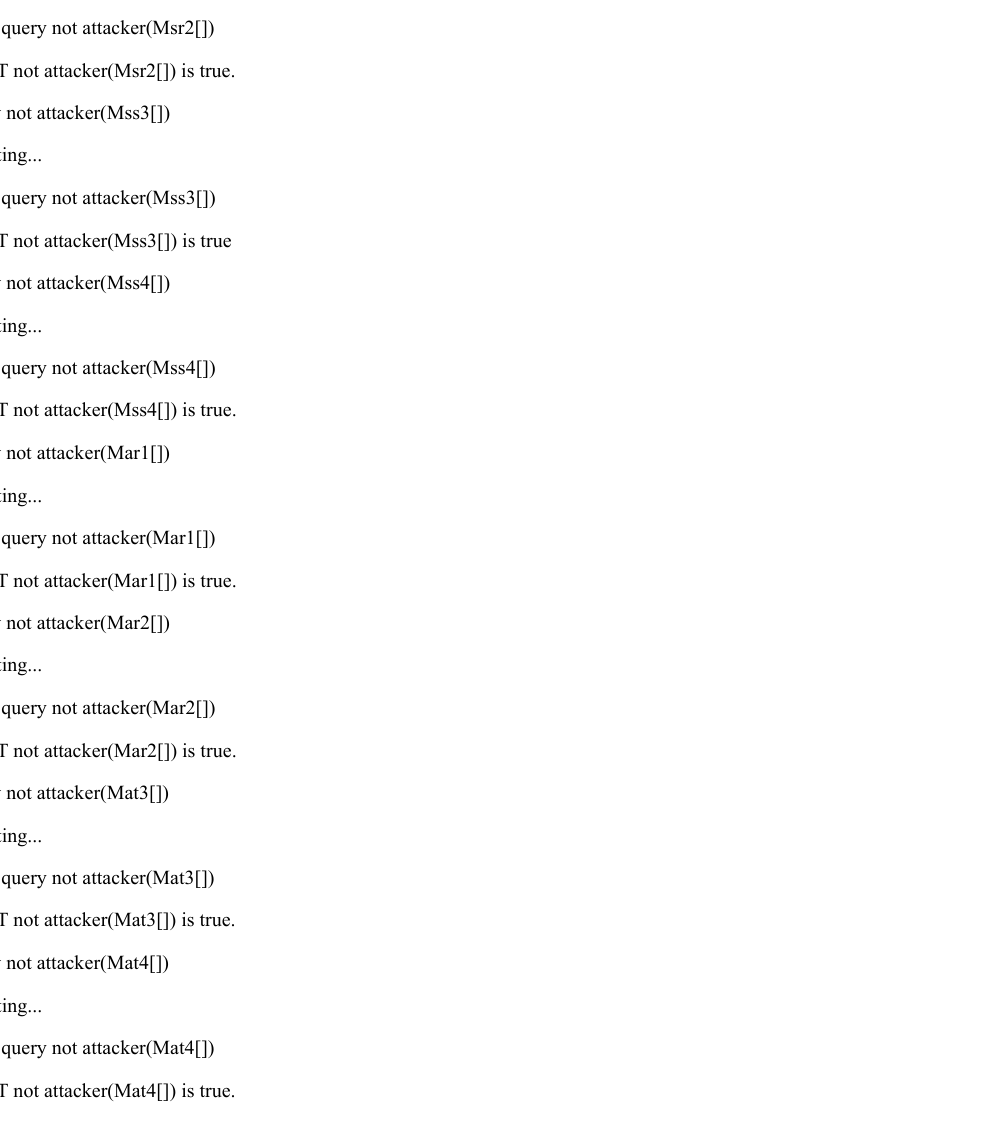
Figure A1. Verification results of reachability and secrecy.